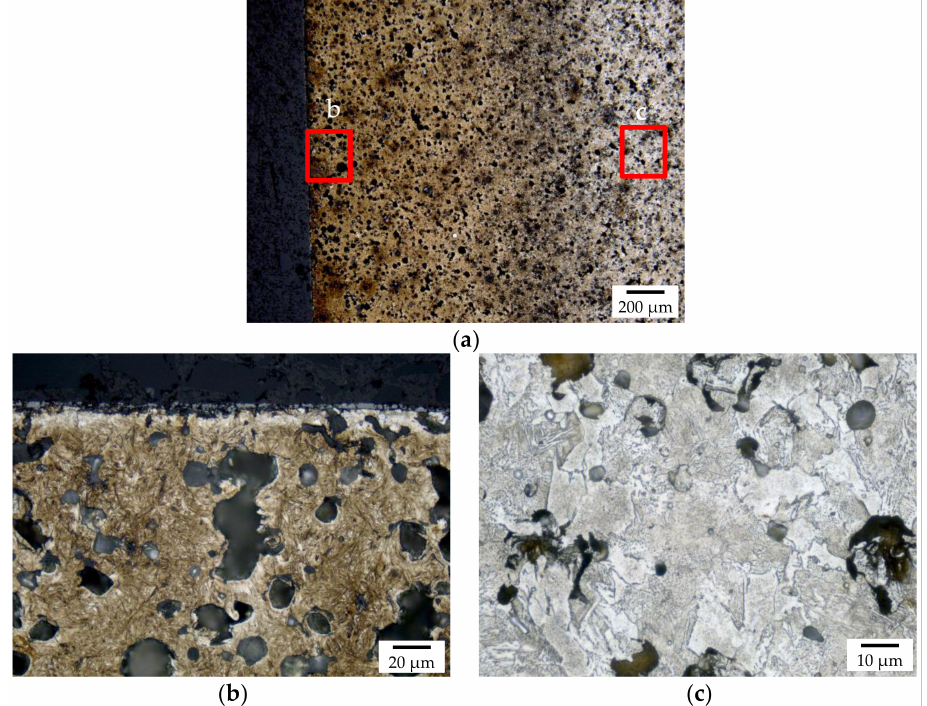
Figure 7. Detailed images of the polished section of the carburized and hardened sample with hollow spheres with ( a ) showing the overview of the case, ( b ) showing the surface near layer, and ( c ) showing the core